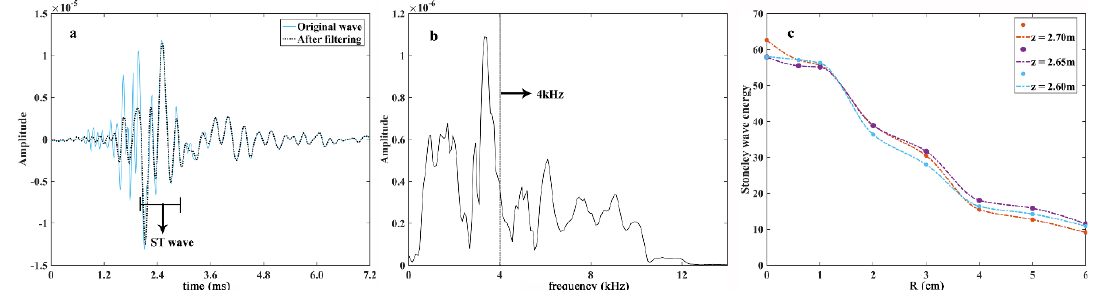
Figure 11. Calculation of ST wave energy and its relationship with cave radius. ( a ) shows the original and the filtered waves. ( b ) shows the frequency spectrum of original wave. ( c ) shows the effect of cave radius on the energy of ST wave. Center frequency of source is 10 kHz. R represents the radius of the cave. z is the axial coordinate.